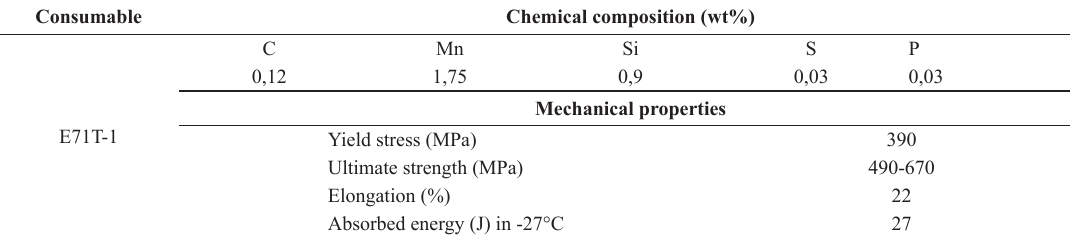
Figure 1: (a) Dimensions of plates for welding and (b) detail of the bevel adopted for the Table 2: Chemical composition and mechanical properties of the consumable for the root pass.